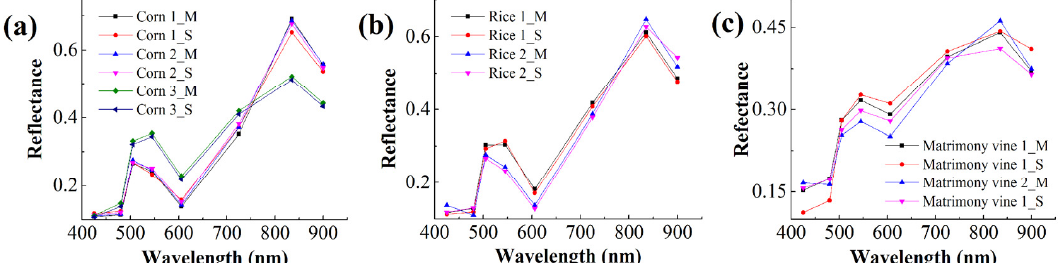
Figure 10. Comparison of the sum of the reflectance simulated by the row model and the reflectance at the top of the canopy measured by the World-View 3 satellite in the vertical viewing direction. ( a ) Corn; ( b ) rice; ( c ) matrimony vine. Here, M represents the data measured by the World-View 3 satellite and S represents the simulated data of the row